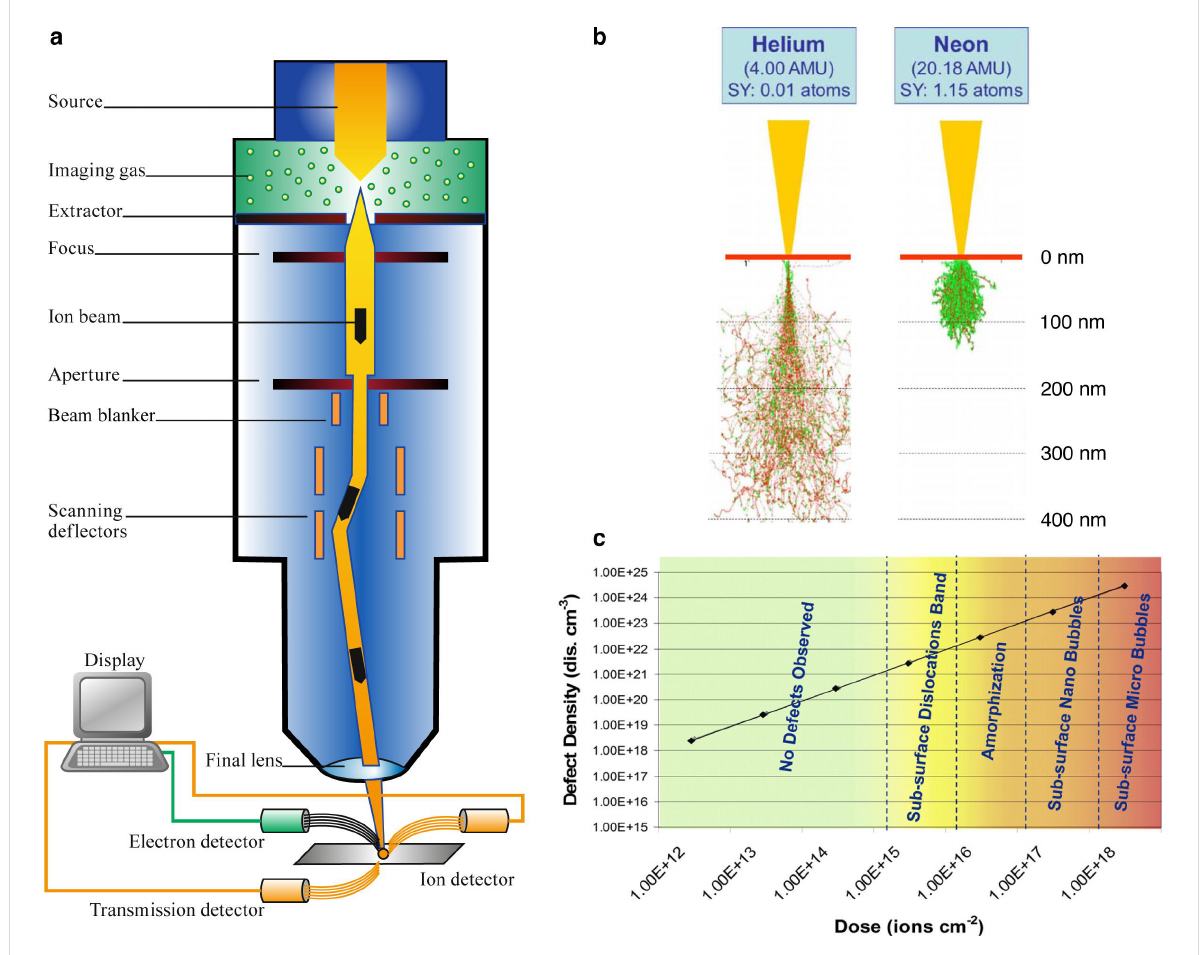
Figure 1: (a) Schematic diagram of the helium ion microscope. Adapted with permission from Cambridge University Press, [2], Morgan et al., An Intro- duction to the Helium Ion Microscope, Microscopy Today, 14(4), 24-31. Copyright 2006 Microscopy Society of America. (b) Simulated interaction volumes for 30 keV helium and neon ions incident on a silicon sample with sputter yield (SY) given for each case. Adapted with permission from [15]. Copyright 2010 American Vacuum Society. (c) Defect density versus dose for helium ions incident on bulk silicon and copper highlighting the threshold doses for various types of subsurface effects. Adapted with permission from [16]. Copyright 2009 American Vacuum Society. This content is not subject to CC BY